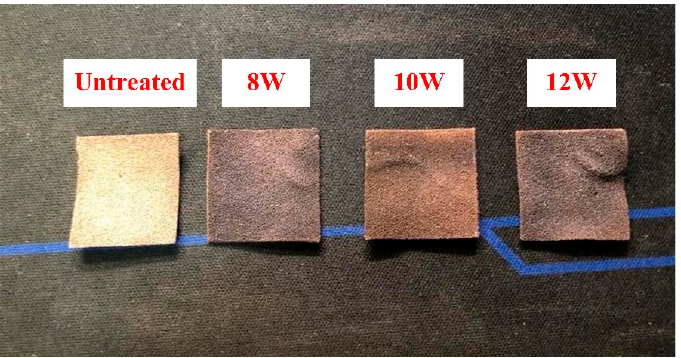
Figure 3. Images of untreated Cu foam and laser-heat treated Cu foams processed with different power